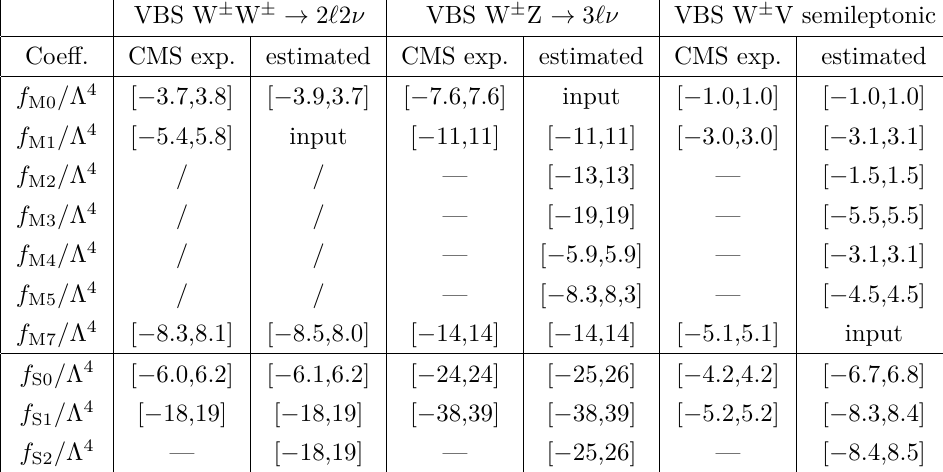
Table 2 . Validation for the VBS CMS analyses. All entries represent 95% CL lower and upper limits in units of TeV − 4 . Input limits to the validation procedures, chosen randomly, are highlighted in the table. Bars represent processes for which there is no sensitivity to the corresponding operator, while dashes represent occurrences of an experimental result not quoted in the CMS